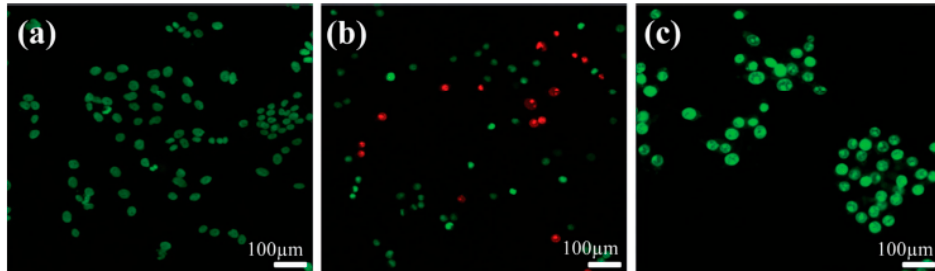
Figure 7. Fluorescence microscopic images of ( a ) osteoblast, ( b ) osteoclast, and ( c ) macrophage cells cultured on Pa-g-nHA/PLGA nanofiber scaffolds. Cells were stained with calcein-AM (green) and propidium iodide (red). Reprinted from Ref. [28] with copyright (2012) permission from the Royal Society of Chemistry.